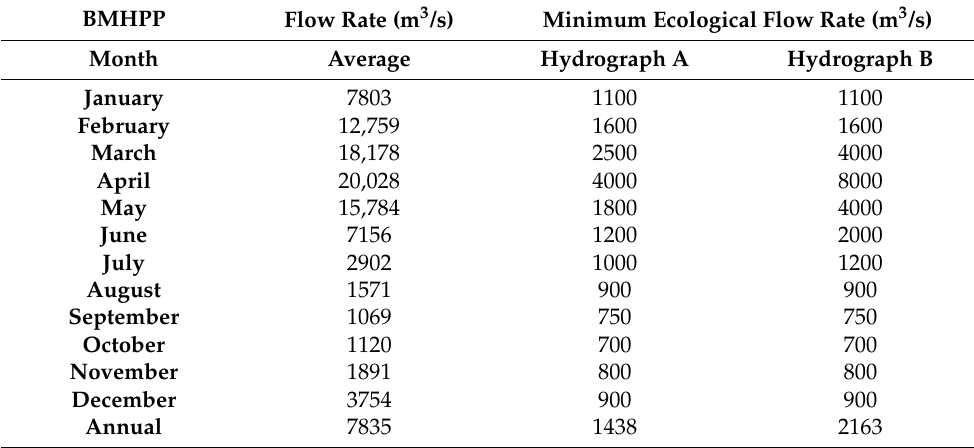
Table 1. Official data from the BMHPP project